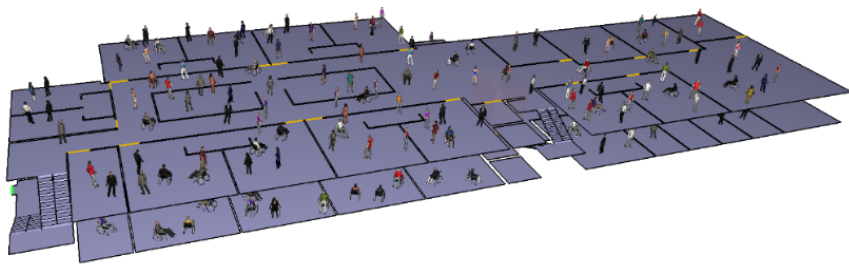
Figure 8. Analysis model for egress simulation. Table 3. Number of patients according to severity.